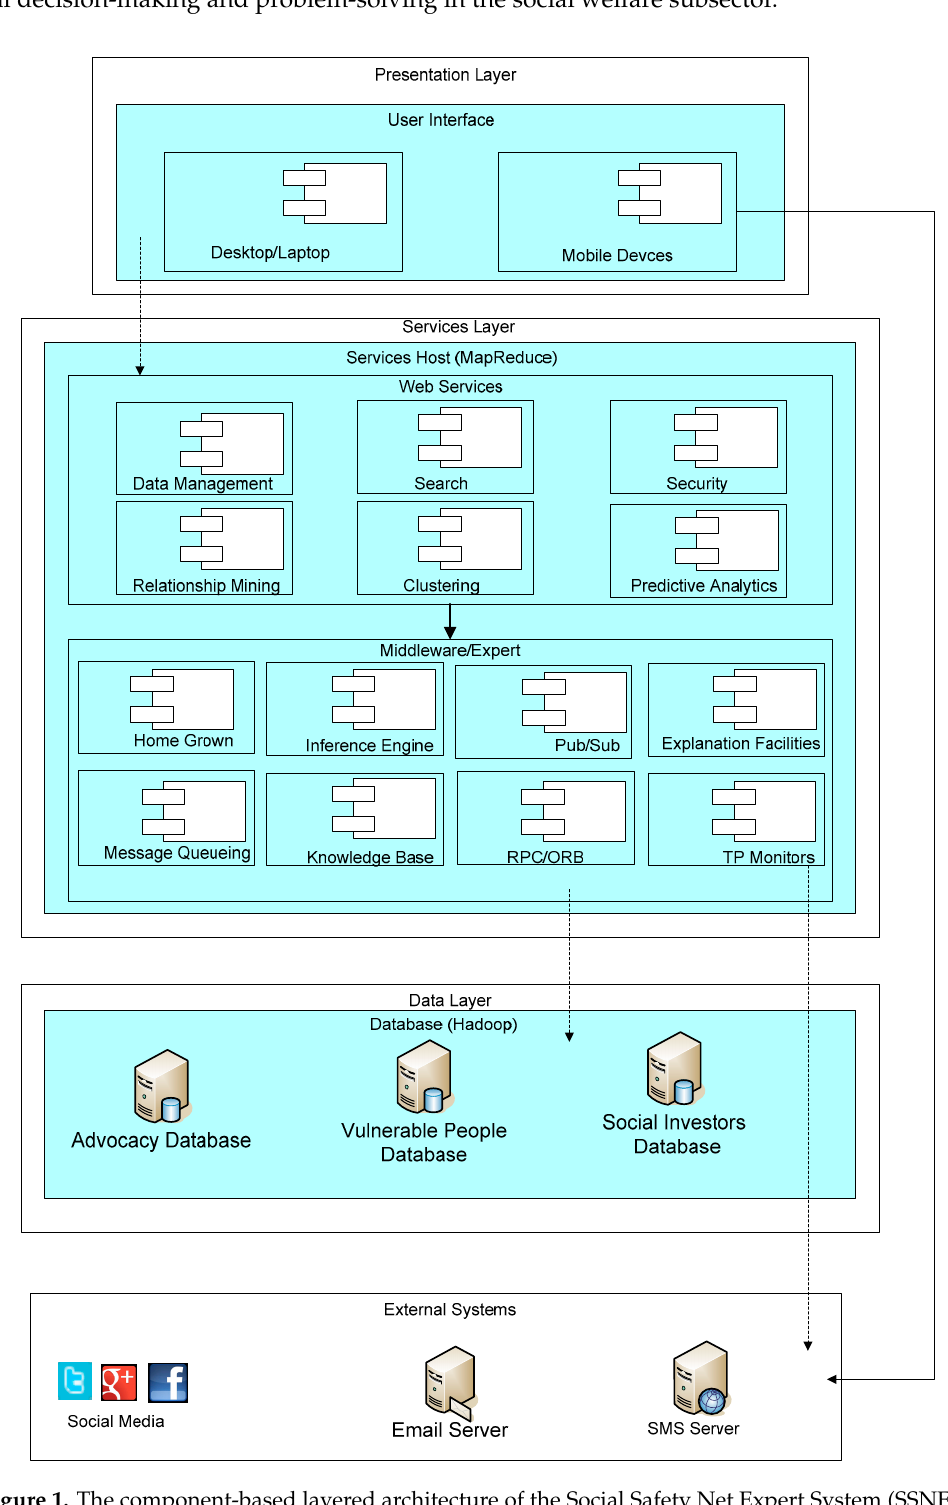
Figure 1. The component-based layered architecture of the Social Safety Net Expert System (SSNES).